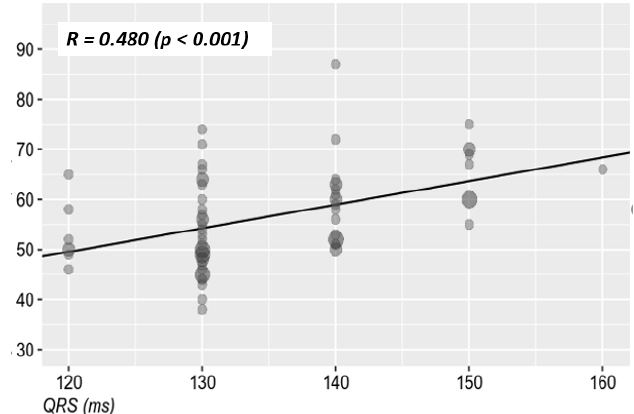
Figure 4. The relationship between the LBBB-QRS complex duration and the diastolic diameter of the left ventricle.